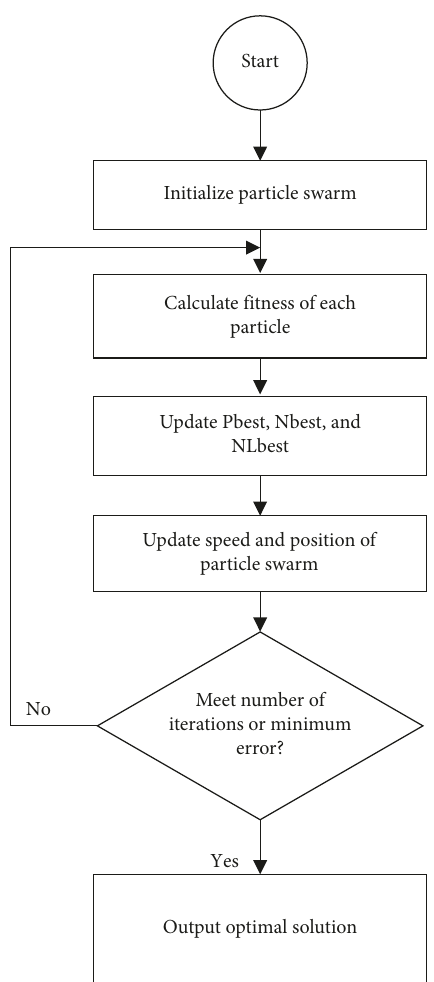
Figure 2: Particle swarm optimization